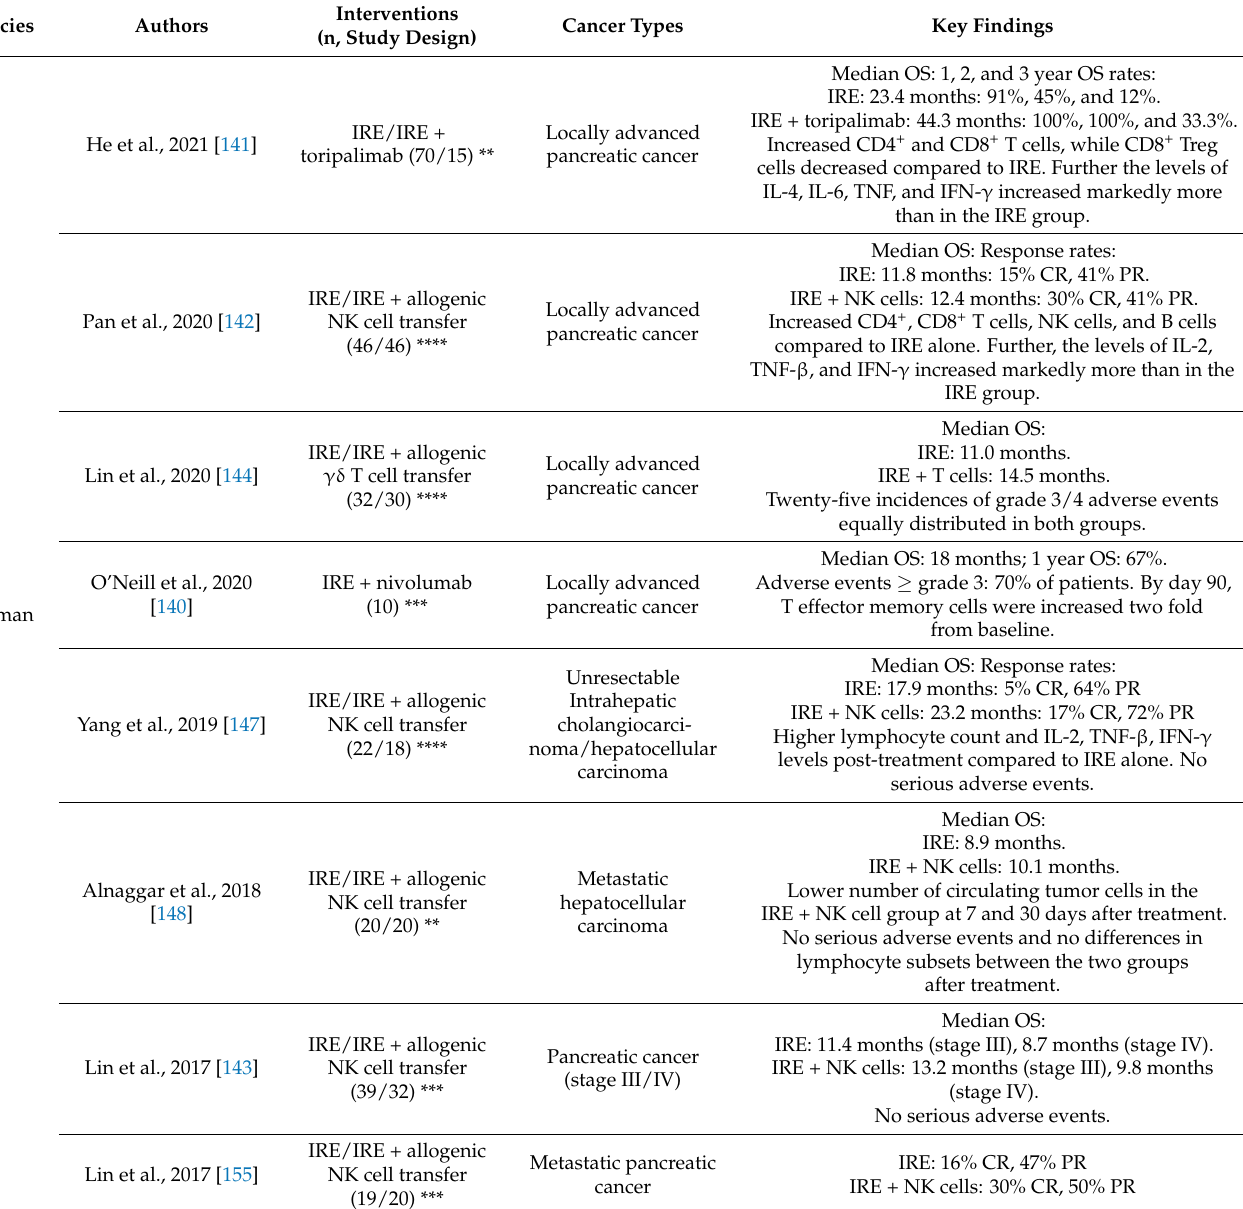
Table 4. Summary of IRE + immunotherapy